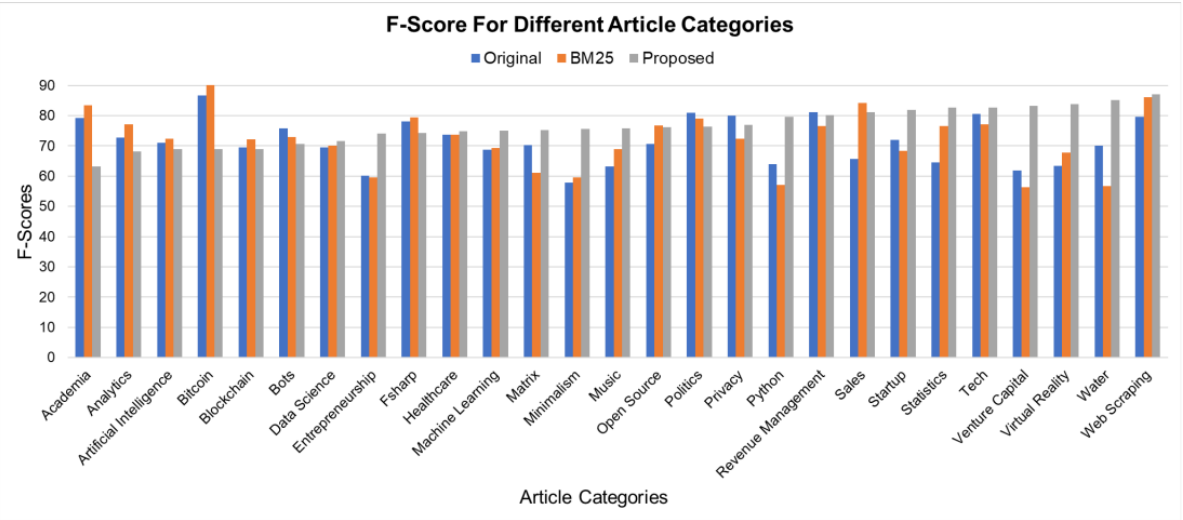
Figure 4. F-Score for different article categories.